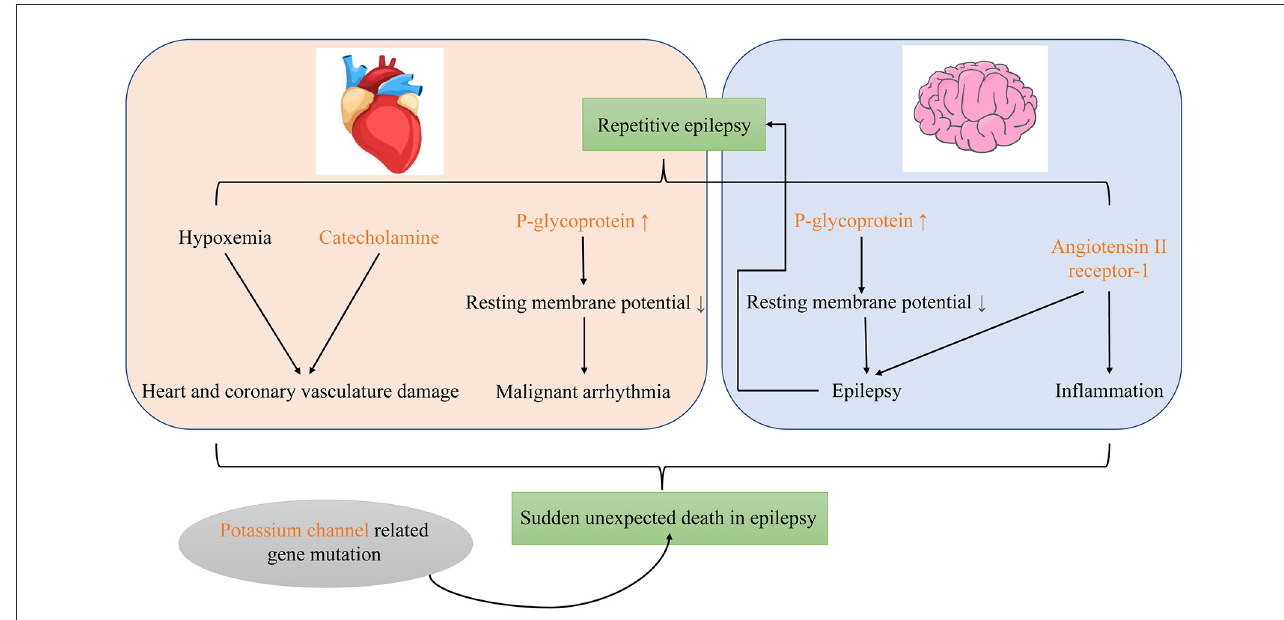
FIGURE1 Possible molecular mechanisms of sudden unexpected death in